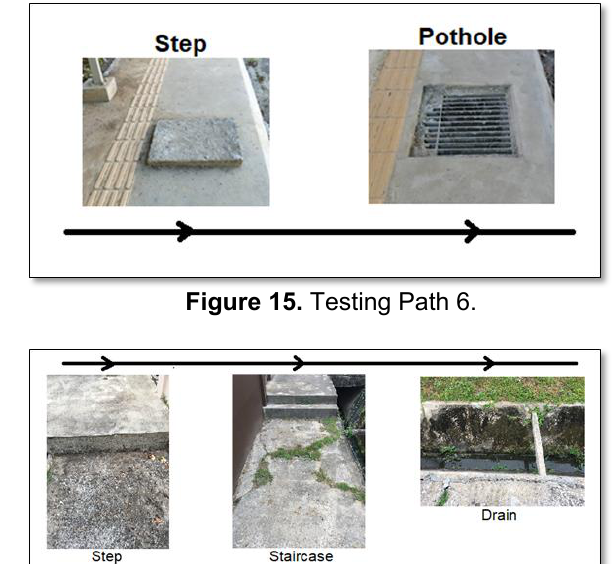
Figure 14. Testing Path 5.